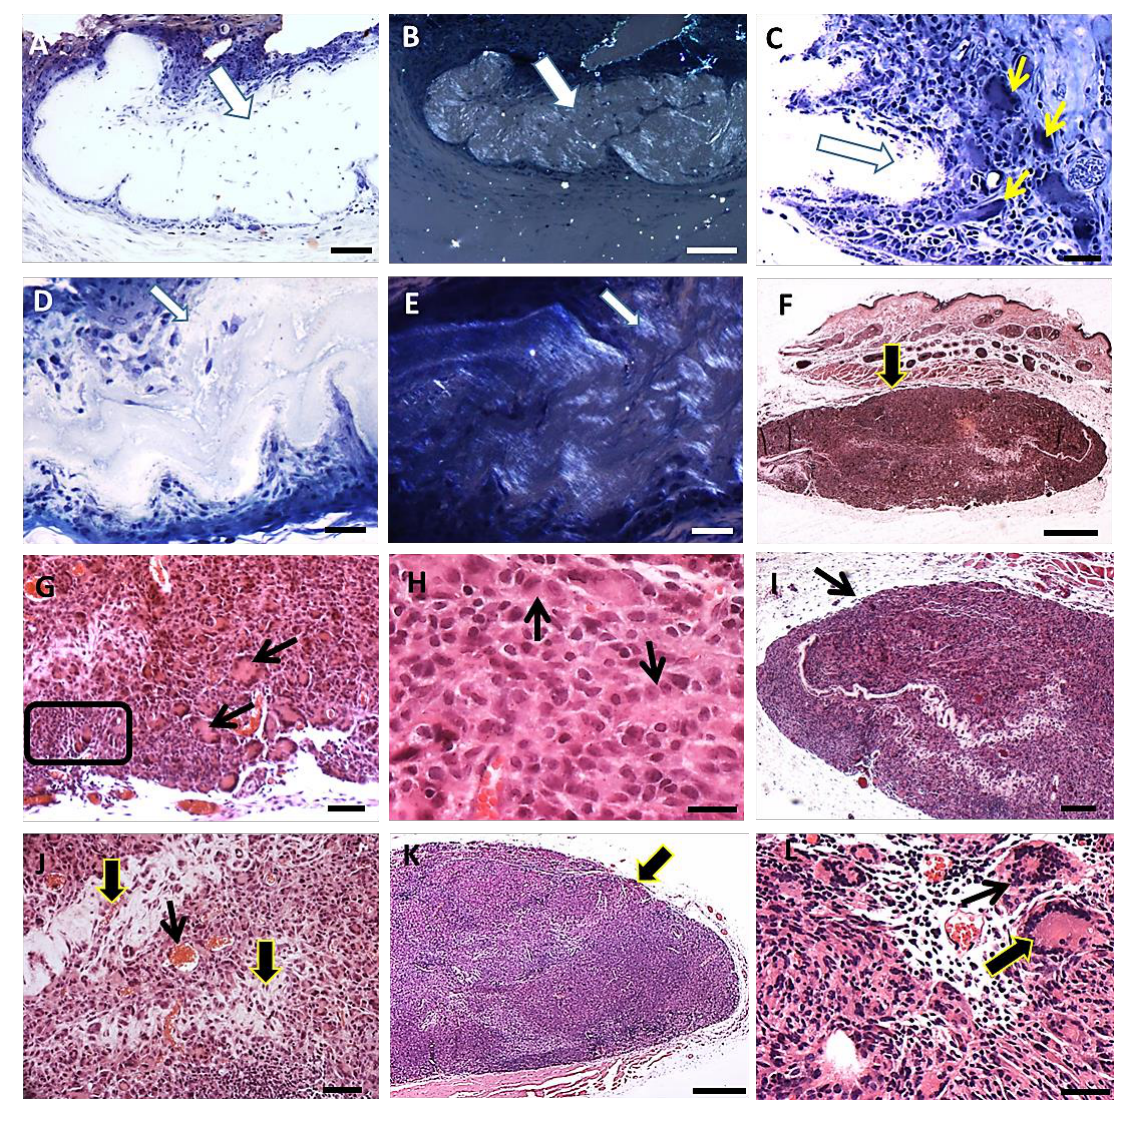
Figure 3. FBR induced by the PLGA membrane: histological features. ( A ): Semi-thin section of a sample in Spurr resin in toluidine blue stain showing the inflammatory response surrounding the membrane (thick arrow) 7 days post implantation (PI). Scale bar: 100µm; ( B ): Polarization light microscopy of the same image in A. Scale bar: 200µm; ( C ): Semi-thin section in Spurr resin and toluidine blue stain showing mononuclear cells and MNGCs (thin yellow arrows) surrounding the membrane (thick arrow) 7 days PI. Scale bar: 100 µm; ( D ): Semi-thin section in Spurr resin in toluidine blue stain showing the FBR 15 days PI. Scale bar: 100 µm; ( E ): Polarization light microscopy of the same image in D. Scale bar: 100 µm; ( F ): Section in Masson’s trichrome stain showing the FBR in the hypodermis 15 days PI (arrow). Scale bar: 1 mm; ( G ): Section in Masson’s trichrome stain showing the FBR 15 days PI; note LCs (arrows) and lymphocytes (square). Scale bar: 200 µm; ( H ): Section in HE stain showing epithelioid cells (arrow) surrounding the membrane. Scale bar: 50 µm; ( I ): Section in HE stain showing the FBR in the hypodermis after 30 days PI (arrow). Scale bar: 500 µm; ( J ): Section in HE stain showing the inflammatory response 30 days PI; connective tissue (thick arrows) and capillaries (thin arrow). Scale bar: 100 µm; ( K ): Section in Masson’s trichrome stains showing the FBR in the hypodermis after 90 days PI; note more cells (arrow). Scale bar: 1 mm; ( L ): Section in HE showing MNGC (thin arrow) and LC (thick arrow) in the inflammatory reaction 90 days PI. Scale bar: 50 µm.